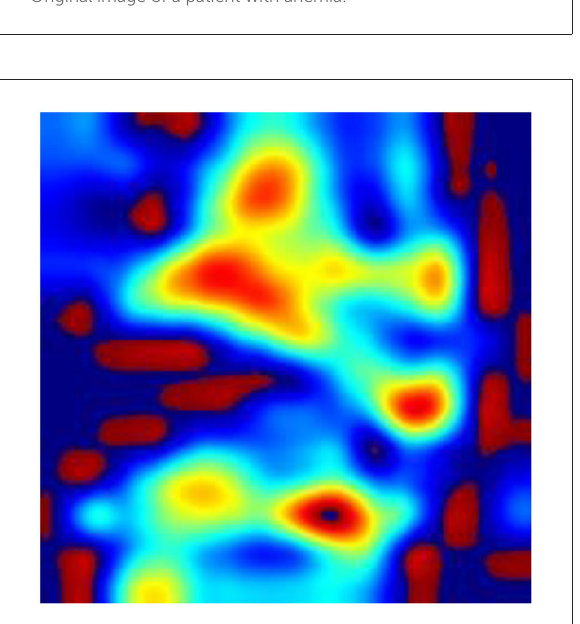
FIGURE9 Support for the anemia category according to visualization of the